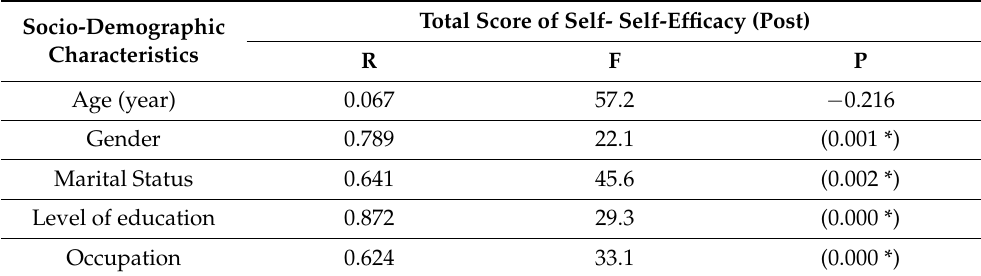
Table 6. Multiple linear regression analysis results: sociodemographic characteristics associated with total self-efficacy score. (N =